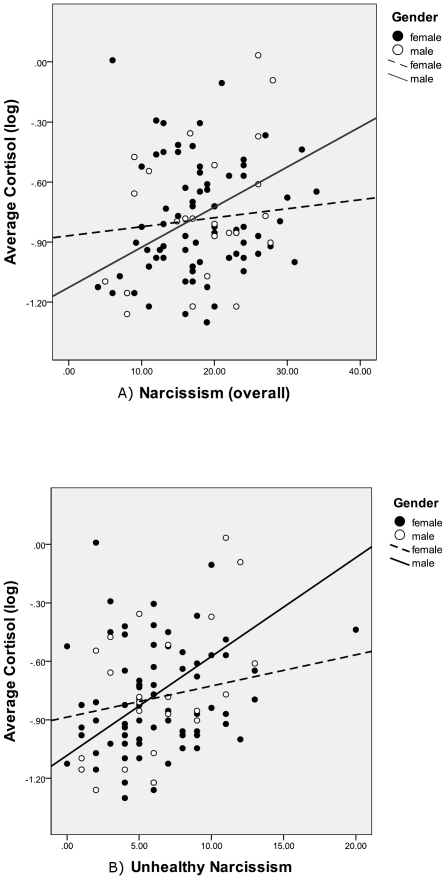
Scatterplot depicting the relationship between cortisol concentrations (log) and (a) overall narcissism, and (b) unhealthy narcissism, with overlaid regression lines.